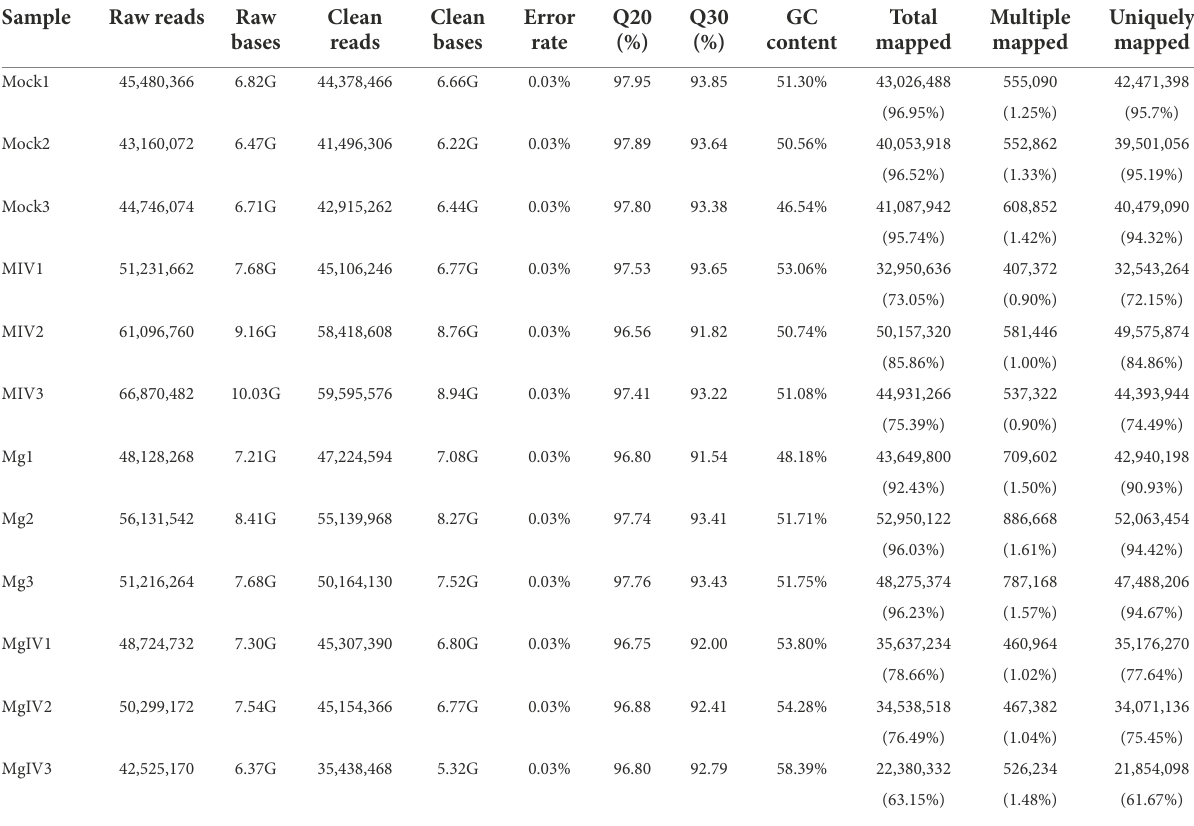
TABLE 1 Summary statistics for sequence quality control and mapped data of sample. Sample